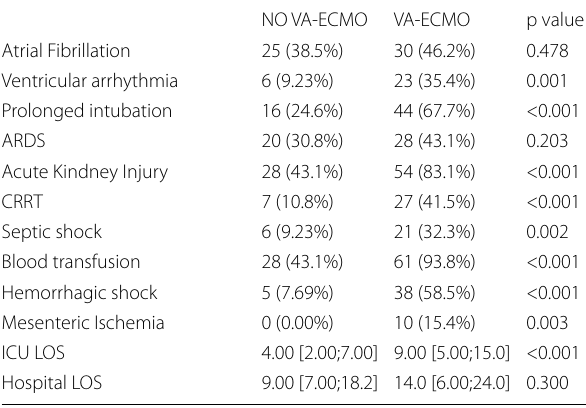
Table 1. In-hospital